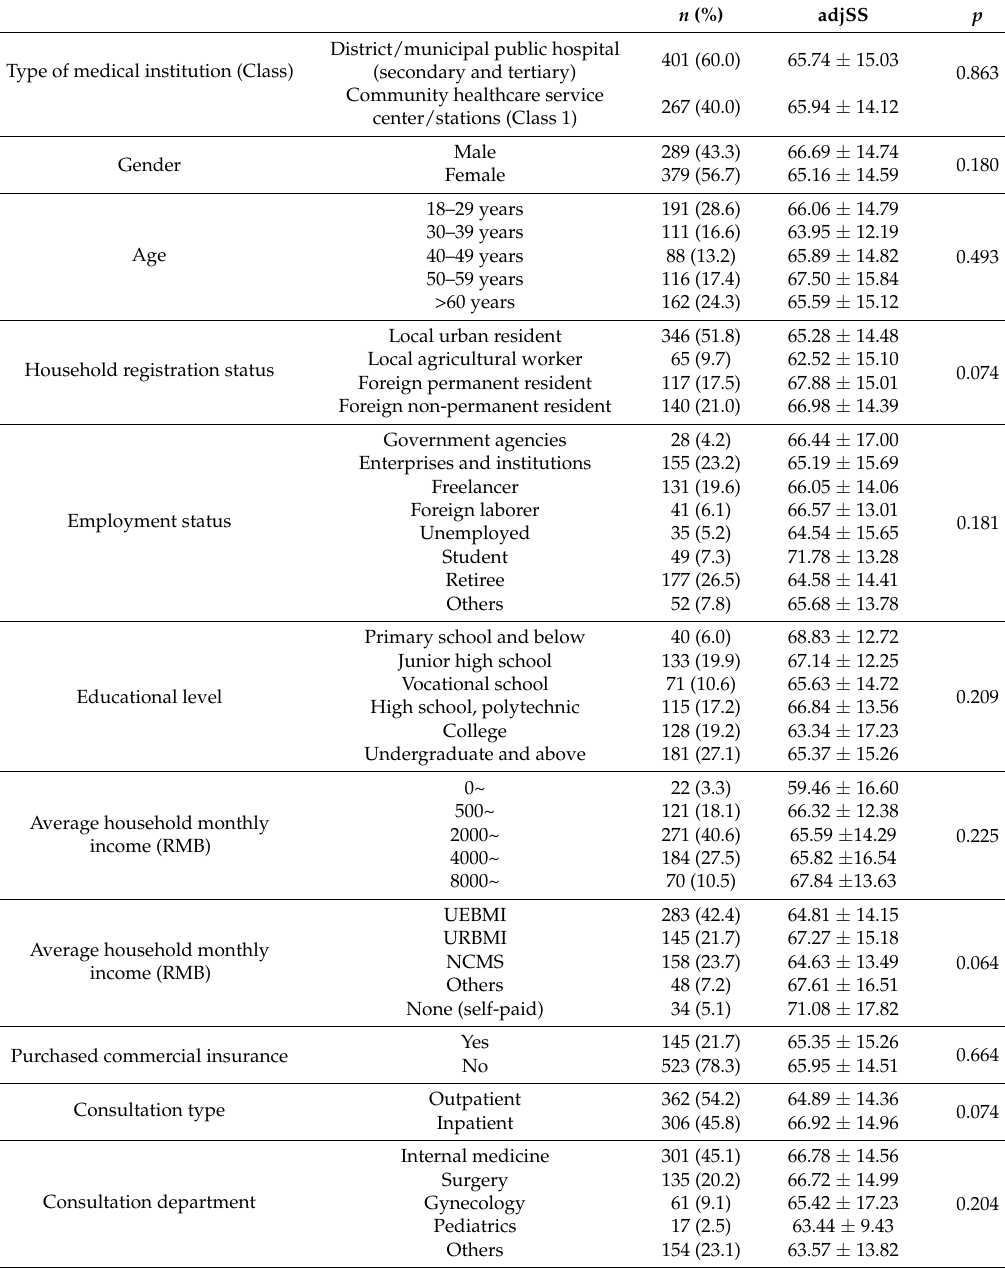
Table 5. Demographic characteristics associated with the patients’ satisfaction ( N =